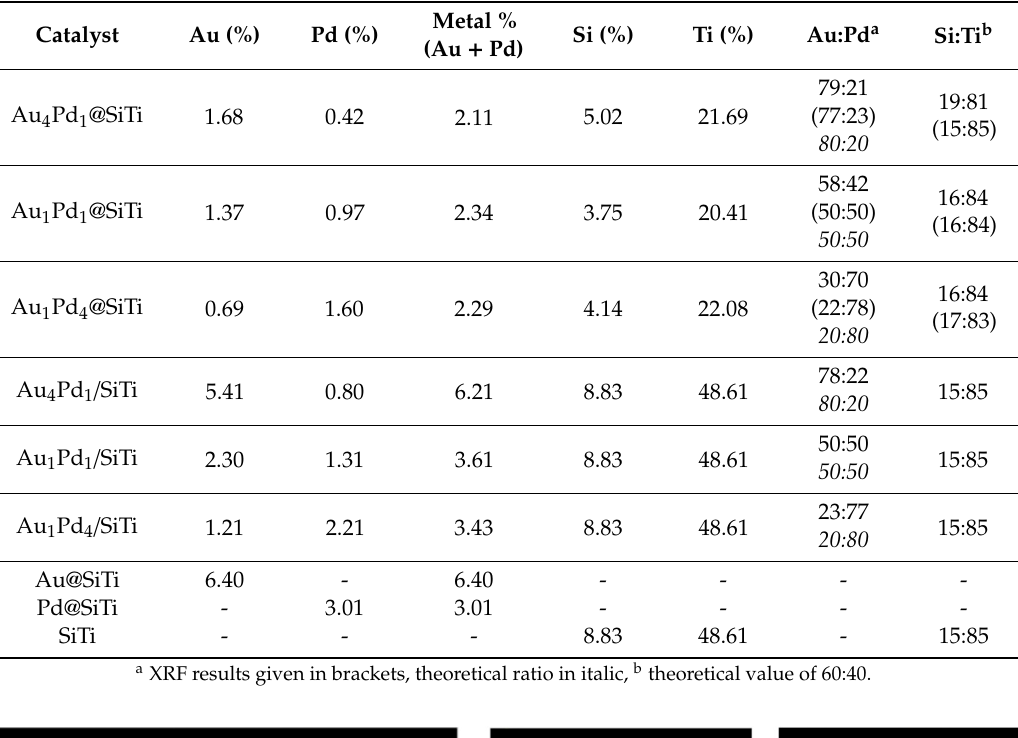
Table 1. Chemical composition of Au x Pd y @SiTi and Au x Pd y / SiTi catalysts as determined by inductively coupled plasma optical emission spectrometry (ICP—OES) and X-ray fluorescence spectrometry (XRF) for the former.